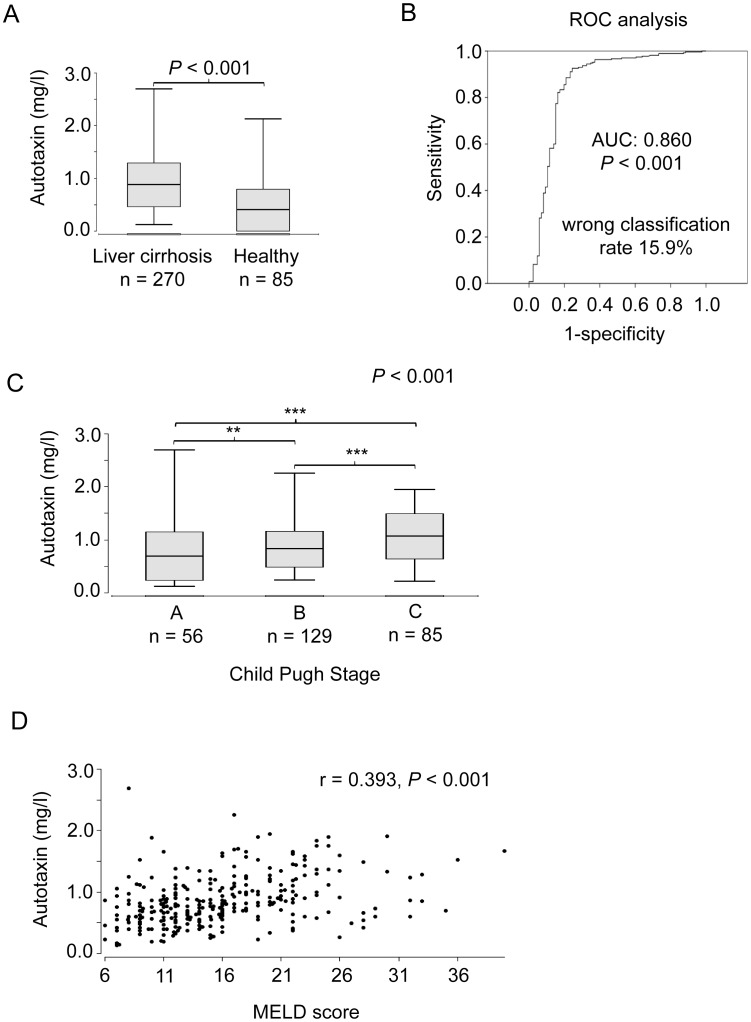
Serum autotaxin levels are elevated in liver cirrhosis and correlate with the stage of cirrhosis.(A) ATX serum concentrations in patients and in healthy subjects. P values referring to differences between the groups were calculated with the Wilcoxon-Mann-Whitney test. (B) AUROC curve for prediction of ATX in liver cirrhosis patients. (C) Serum ATX levels in patients with different Child-Pugh stages, P values referring to differences between the groups are calculated with the Kruskal-Wallis test (**P<0.01; ***P<0.001). The Bonferroni correction was used for the subgroup comparisons. (D) Correlation between MELD score and ATX serum levels in patients with liver cirrhosis. The correlation coefficient was calculated by the Spearman test.